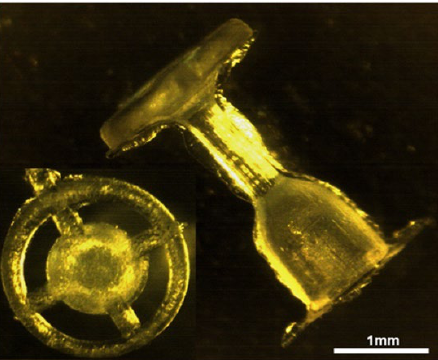
Figure 9. Middle-ear prosthesis for ossicular reconstruction made of ABS polymer. Adapted from an open-access source: [158] .